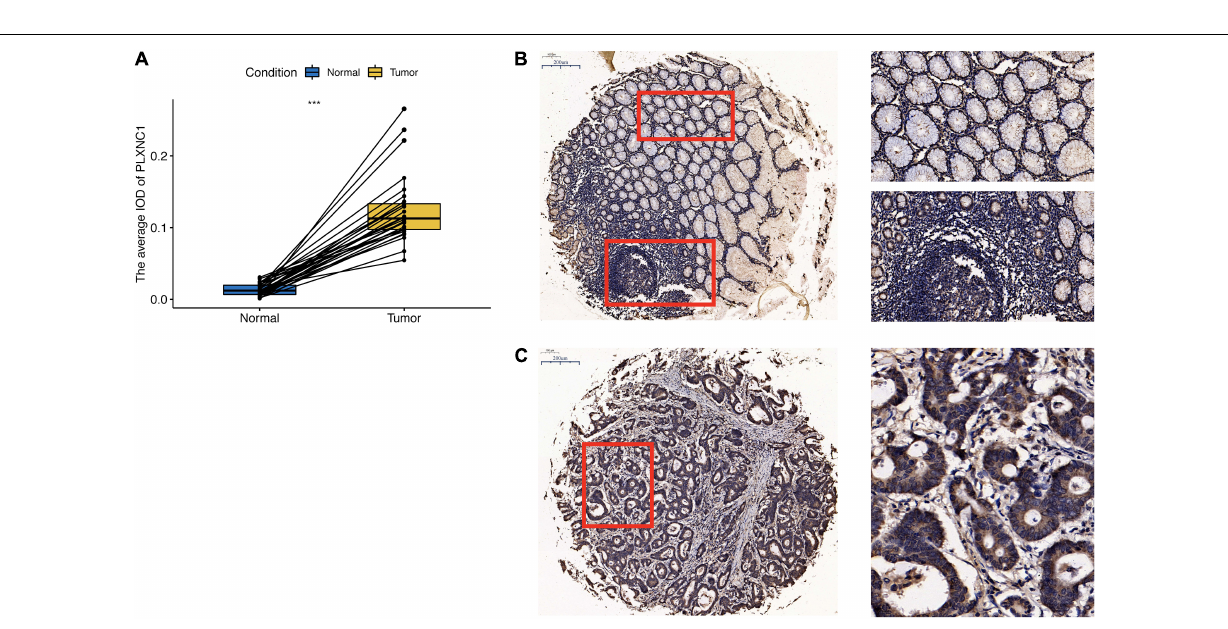
Frontiers in Cell and Developmental Biology |